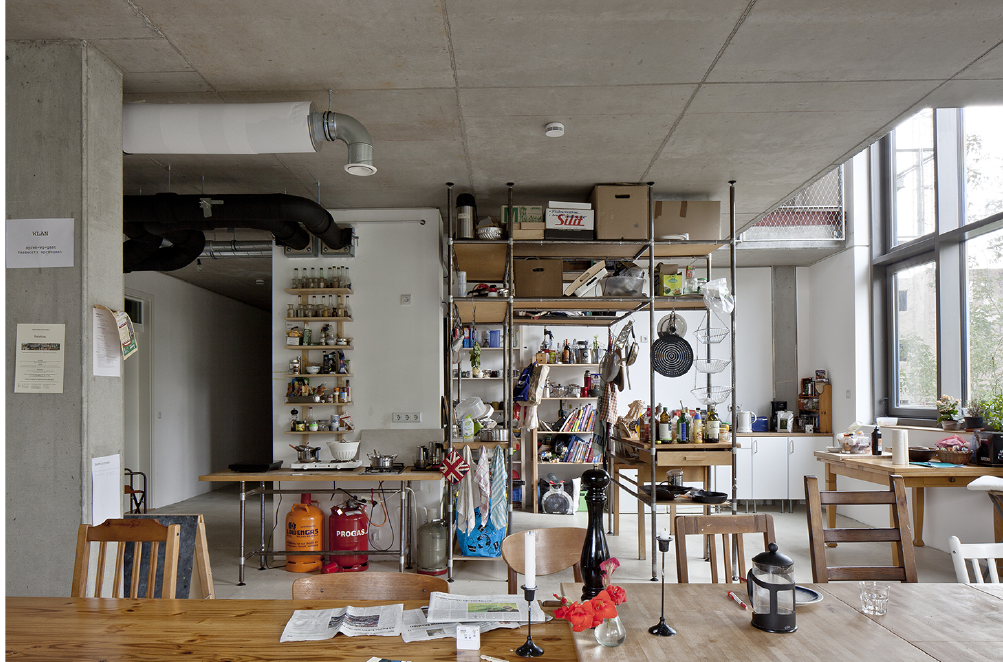
Figure 13. Spreefeld Genossenschaft (shared kitchen and dining room), Berlin, 2014, by Carpaneto Architekten, Fatkoehl Architekten and BARarchitekten. Image courtesy of Fatkoehl Architekten. space with shared facilities (see Figures 14 and 15);